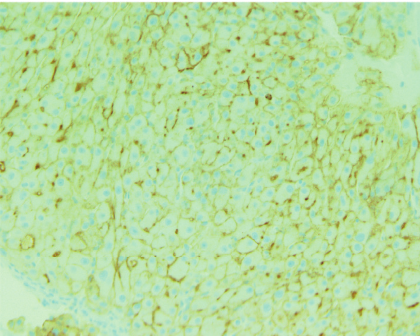
Figure 6: Positive polyclonal CEA staining, diffuse canalicular pattern (histopathology and immunostaining of forehead